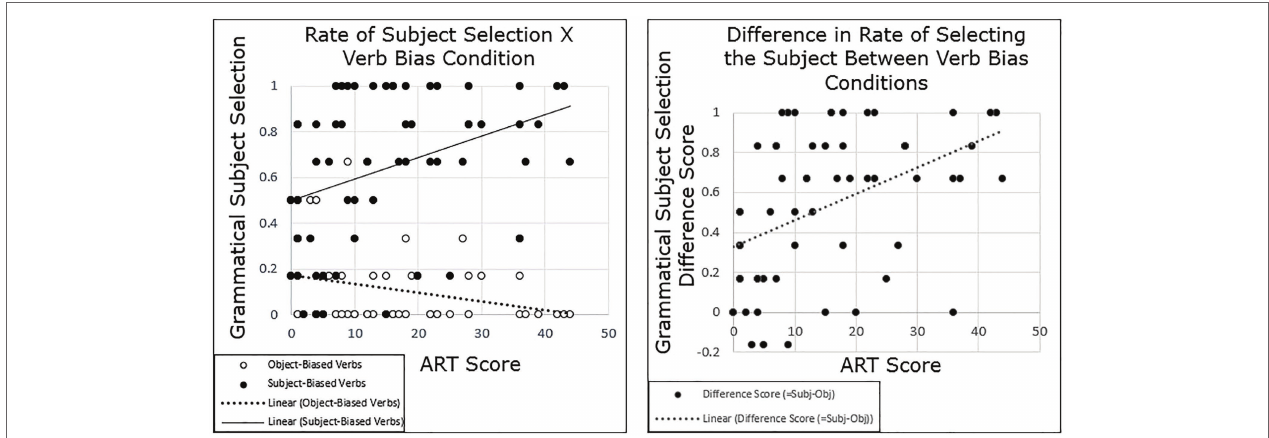
FIGURE 2 | Experiment 1 results: participants with higher Author Recognition Task (ART) scores show a stronger semantic bias than those with lower ART scores. (Left panel) Each dot represents the participant’s average rate of selecting the subject in each condition, such that there are two dots shown per participant. (Right panel) This graph depicts differences scores, such that each participant’s average rate of subject selection in the object-biased verb condition was subtracted from their average rate of subject selection in the subject-biased verb condition. This demonstrates the variability of the semantic bias for each participant.